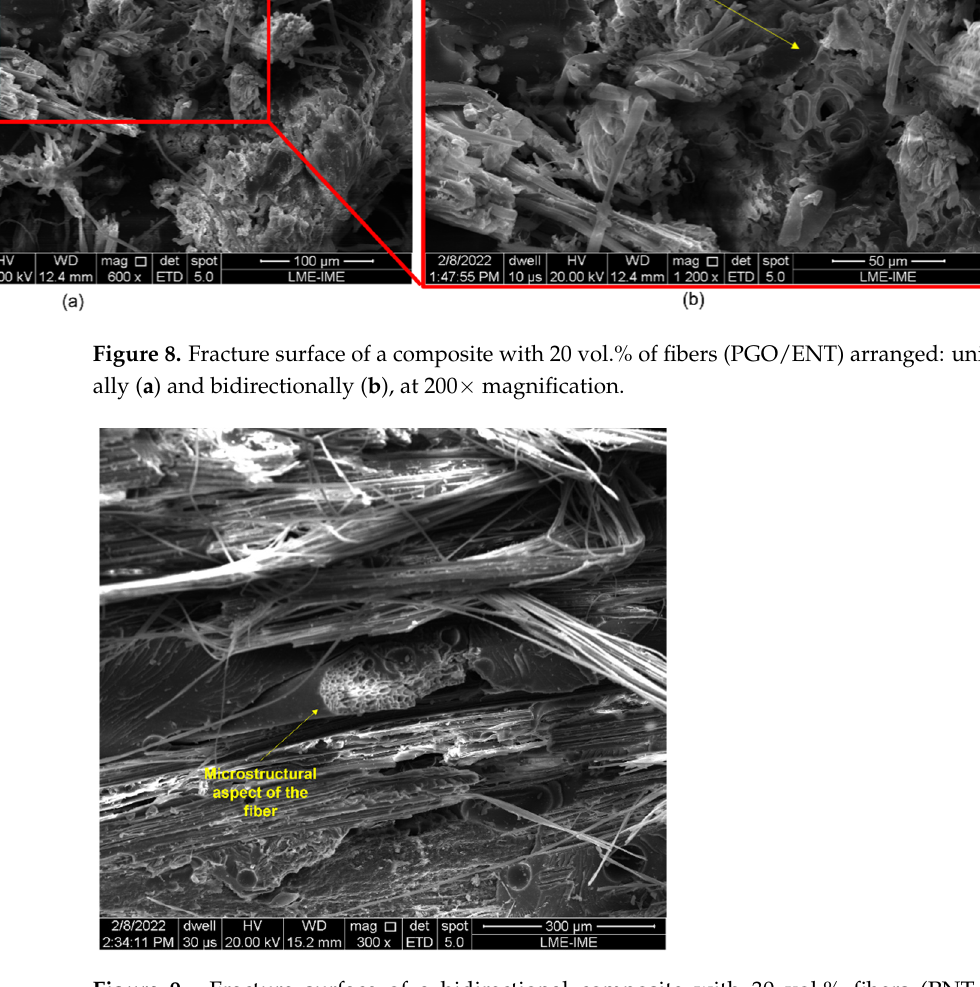
Figure 10. Fracture surface of a composite with 20 vol.% of fibers (PNT/EGO) arranged: unidirec- tionally ( a ) and bidirectionally ( b ), at 200× magnification.